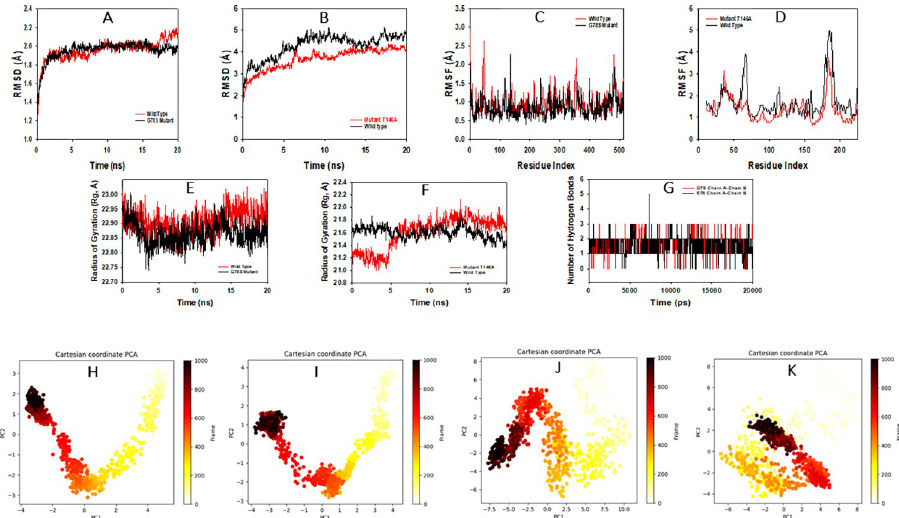
Fig 5. Analysis of MD simulation trajectories of 20 ns time scale. (A) RMSD plot displaying the molecular vibration of C α backbone of wild type (red), and G78S mutant (black). (B) RMSD plot displaying the molecular vibration of C α backbone of wild type mitochondrial ATPase (black), and T146A mutant (red). (C) RMSF plots show the fluctuations of respective amino acids throughout the simulation time 20 ns wild type (red), and G78S mutant (black). (D) RMSF plots show the fluctuations of respective amino acids throughout the simulation time 20 ns wild type mitochondrial ATPase (black), and T146A mutant (red). (E) The radius of gyration plots for the deduction of compactness of protein wild type (red), and G78S mutant (black). (F) Radius of gyration plots for wild type mitochondrial ATPase (black), and T146A mutant (red). (G) Number of hydrogen bonds formed between G78 and chain B (red) and S78 and chain B (black) during 20 ns simulation time scale. Principal Component Analysis (PCA) of (H) wild type chain A domain and (I) G78S mutant, (J) wild type ATPase and (K) mutant T146A, into unordered (yellow) to ordered (black) clusters, while comparing PC1 and PC2 for 20 ns simulation